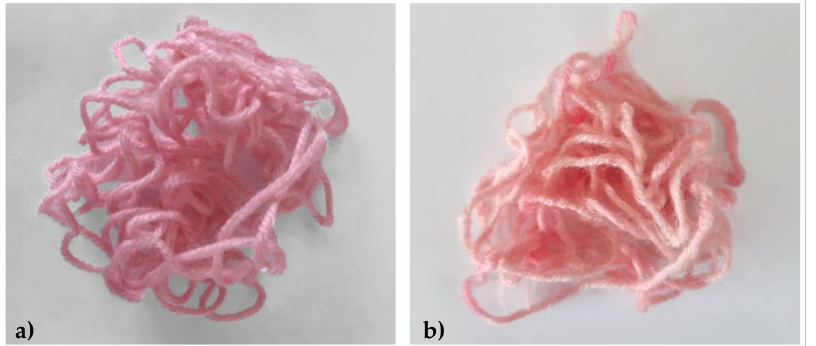
Figure 11. The visual appearance of wool yarn dyed with plant-derived anthocyanins in the presence (( a ), WoolP_1) or absence (( b ), WoolP_2) of potassium alum as a